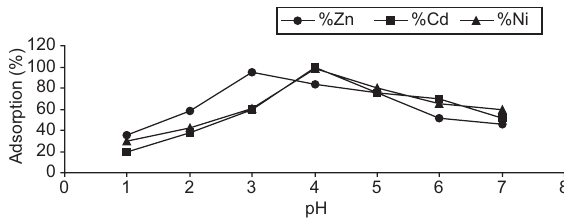
Figure 1 The effect of pH on the retention of metals on Lewatit TP